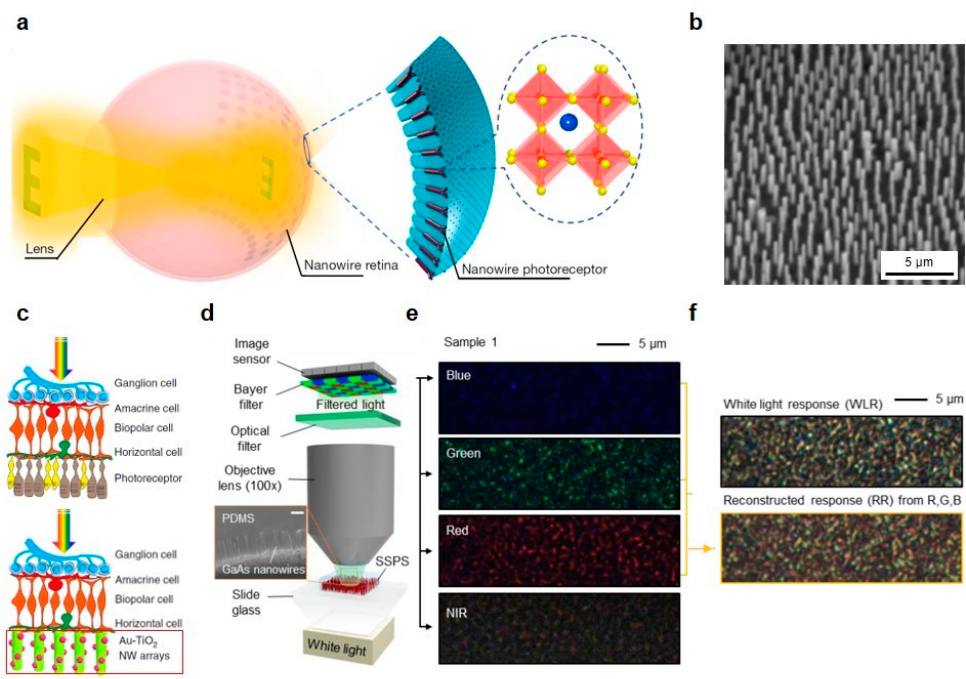
Figure 7. ( a ) Schematic of the spherical biomimetic electrochemical eye (EC-EYE) system with an enlarged illustration of perovskite nanowire photoreceptor arrays. ( b ) SEM image of perovskite nanowires. ( c ) Schematic of the rod and cone cells in necrotic photoreceptor layer replacement with artificial photoreceptors of Au-TiO 2 nanowire array. ( d ) Schematic of the optical setup for the selective absorption measurement of the selective and sensitive photon sieve (SSPS). SEM image of the SSPS (inset). ( e ) Filtered optical microscope images of SSPS with 450 nm, 550 nm, 632.8 nm and 750 nm filtered lights. ( f ) White light response (top) and reconstructed response (bottom) from red, green and